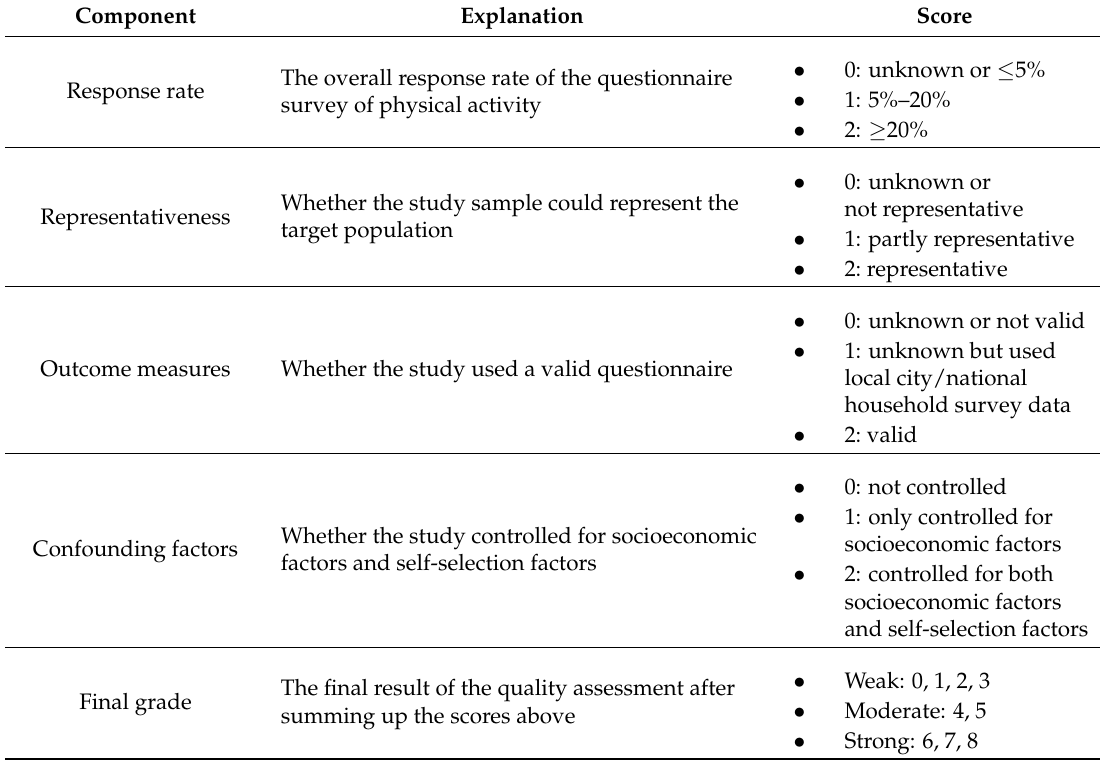
Table 3. Criteria used in the quality